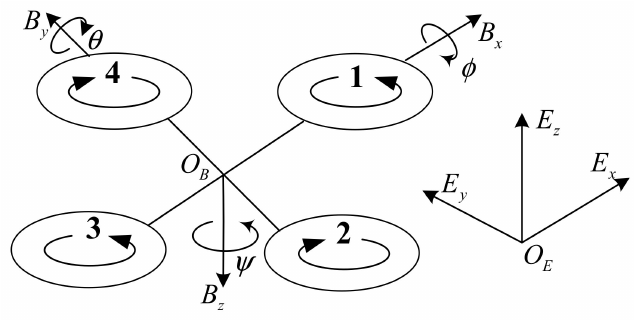
Figure 1. Typical structure of a